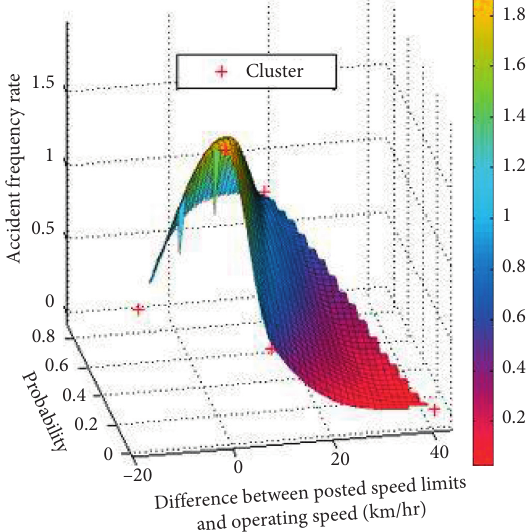
Figure 5: Examination of the effect of the difference between posted speed limits and the operating speed on the accident fre- quency rate.